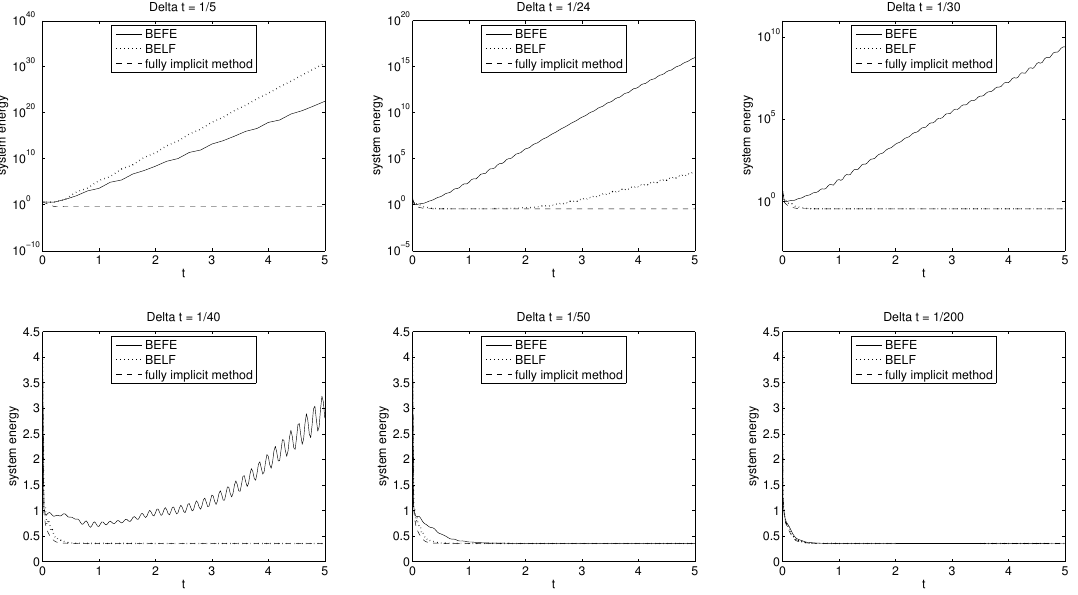
Figure 1. The evolution of system energy with k min = 10 − 6 for different choices of time step [28]. Copyright c (cid:13) 2013 Society for Industrial and Applied Mathematics. Reprinted with permission. All rights